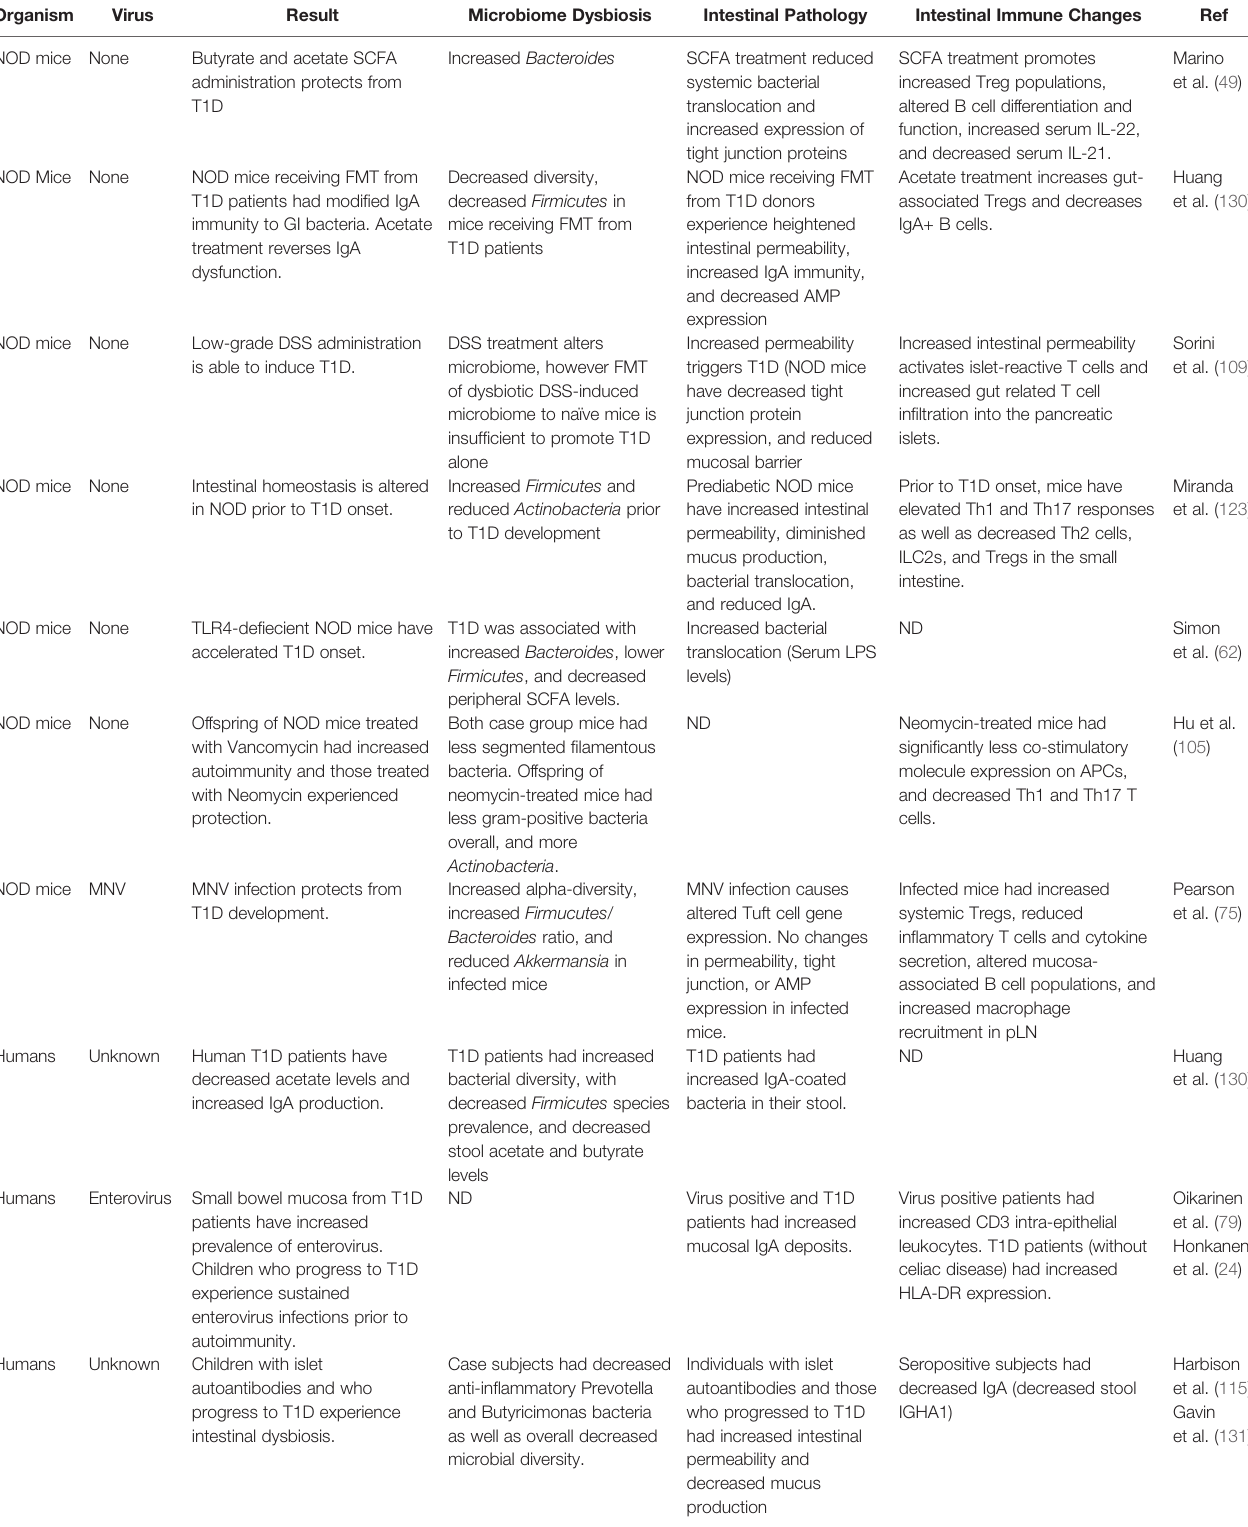
TABLE 1 | Highlighted recent studies depicting intestinal changes associated with